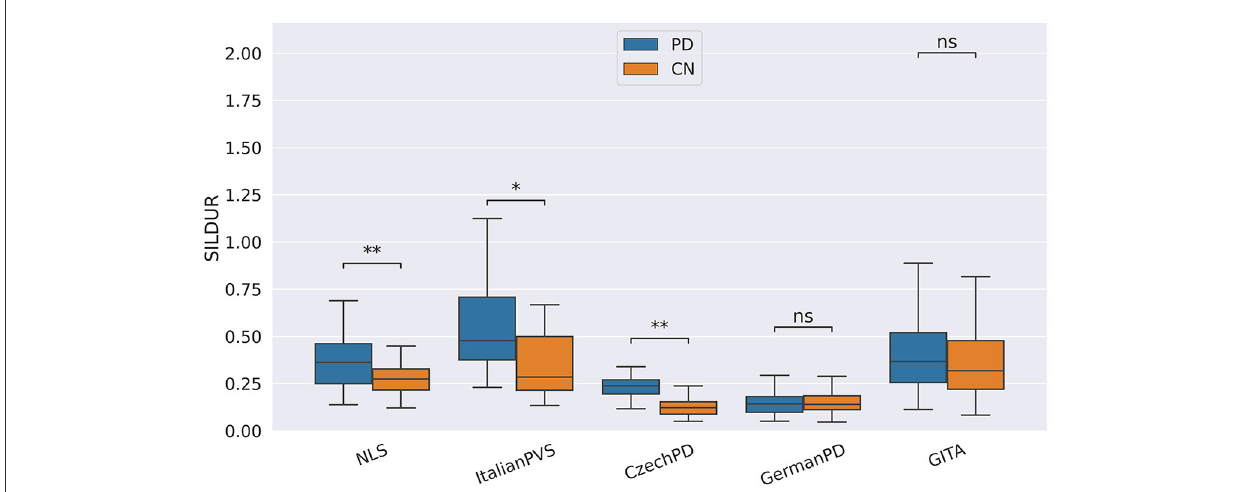
FIGURE2 Boxplots with statistical annotations representing the silence duration (SILDUR) on NLS, Neurovoz, CzechPD, GermanPD, and GITA from the RP task. Horizontal lines represent the median, the top ends represent the upper quartile, and the bottom ends represent the lower quartile. Statistically significant differences between groups after Benjamini–Hochberg correction for SILDUR are reported in Table 5 and highlighted below using asterisks. SILDUR, silence duration; CN, controls; PD, Parkinson’s disease; SILDUR, silence duration; SS, spontaneous speech; ns, not